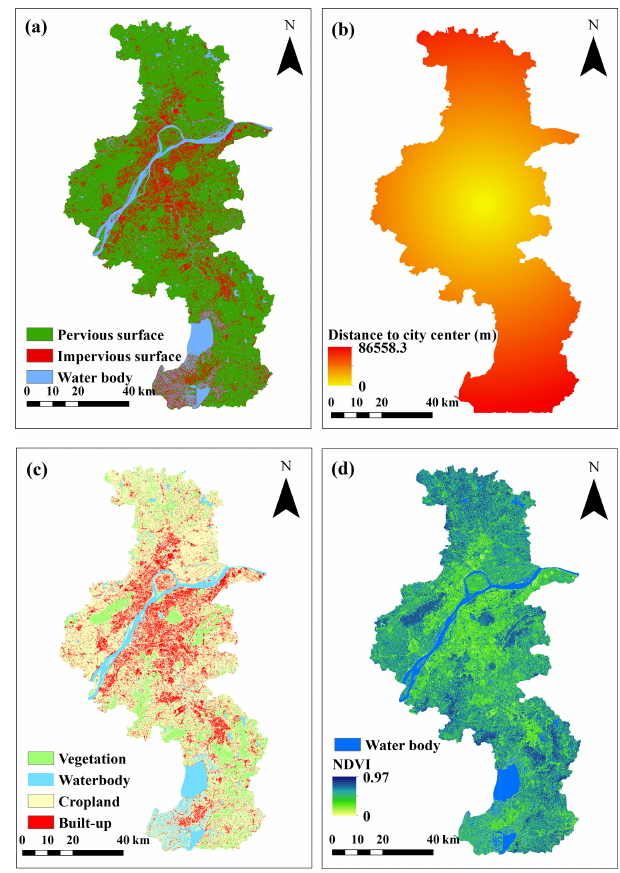
Figure 2. Spatial distribution of typical environmental variables on 21 July 2017 in Nanjing: (a) impervious surface; (b) distance from city center; (c) LULC; (d) NDVI.